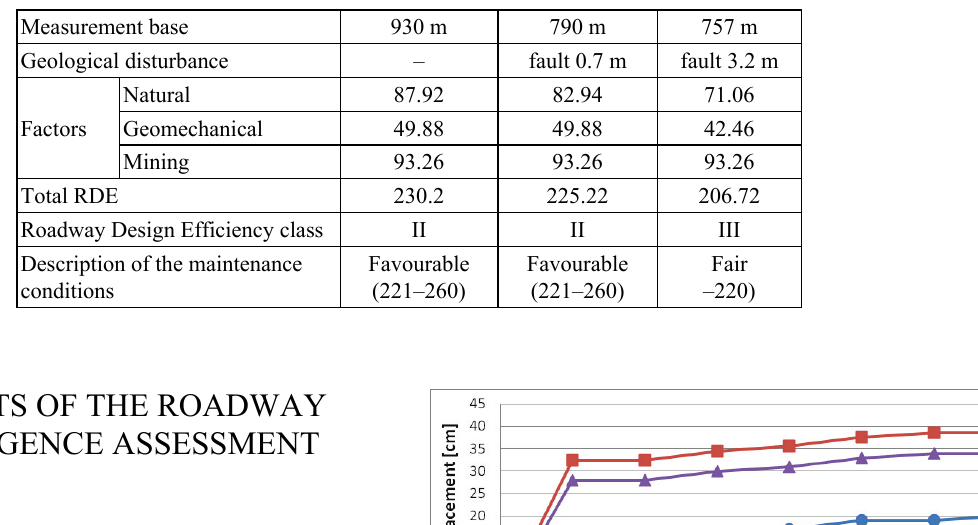
Cross- -section changeDate of